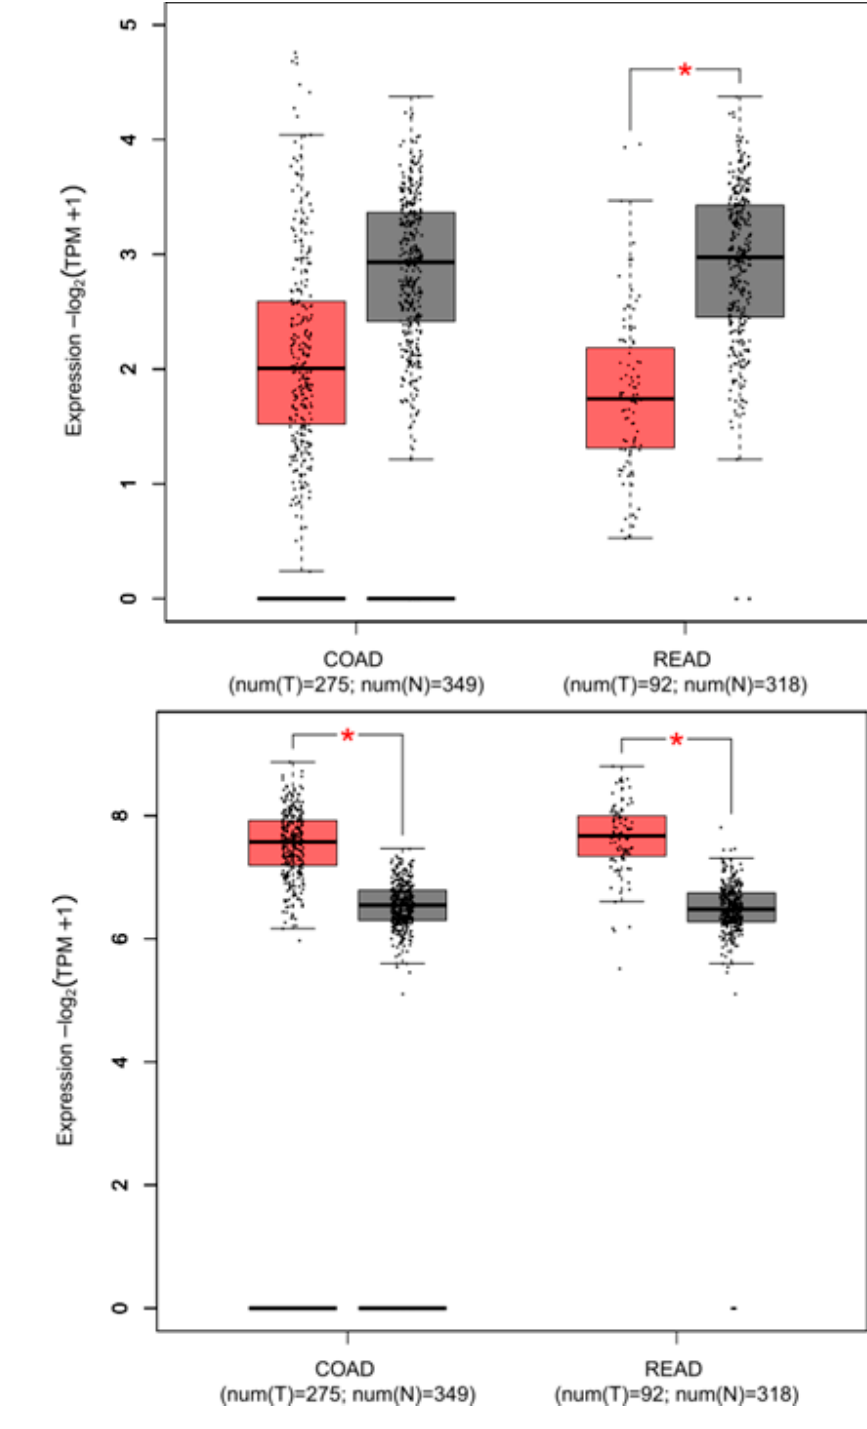
Figure 2. KCTD1 (( A ), top panel) and β -catenin (( B ) low panel) mRNA expression in colon adenocarcinoma (COAD) and rectum adenocarcinoma (READ) and normal tissues (GEPIA2). Box plots show median KCTD1 mRNA expression levels in tumour tissues (red plots) and normal tissues (grey plot). Axis units are Log2 (TPM + 1). * red = p < 0.01. T = tumour tissues. N = normal tissues.